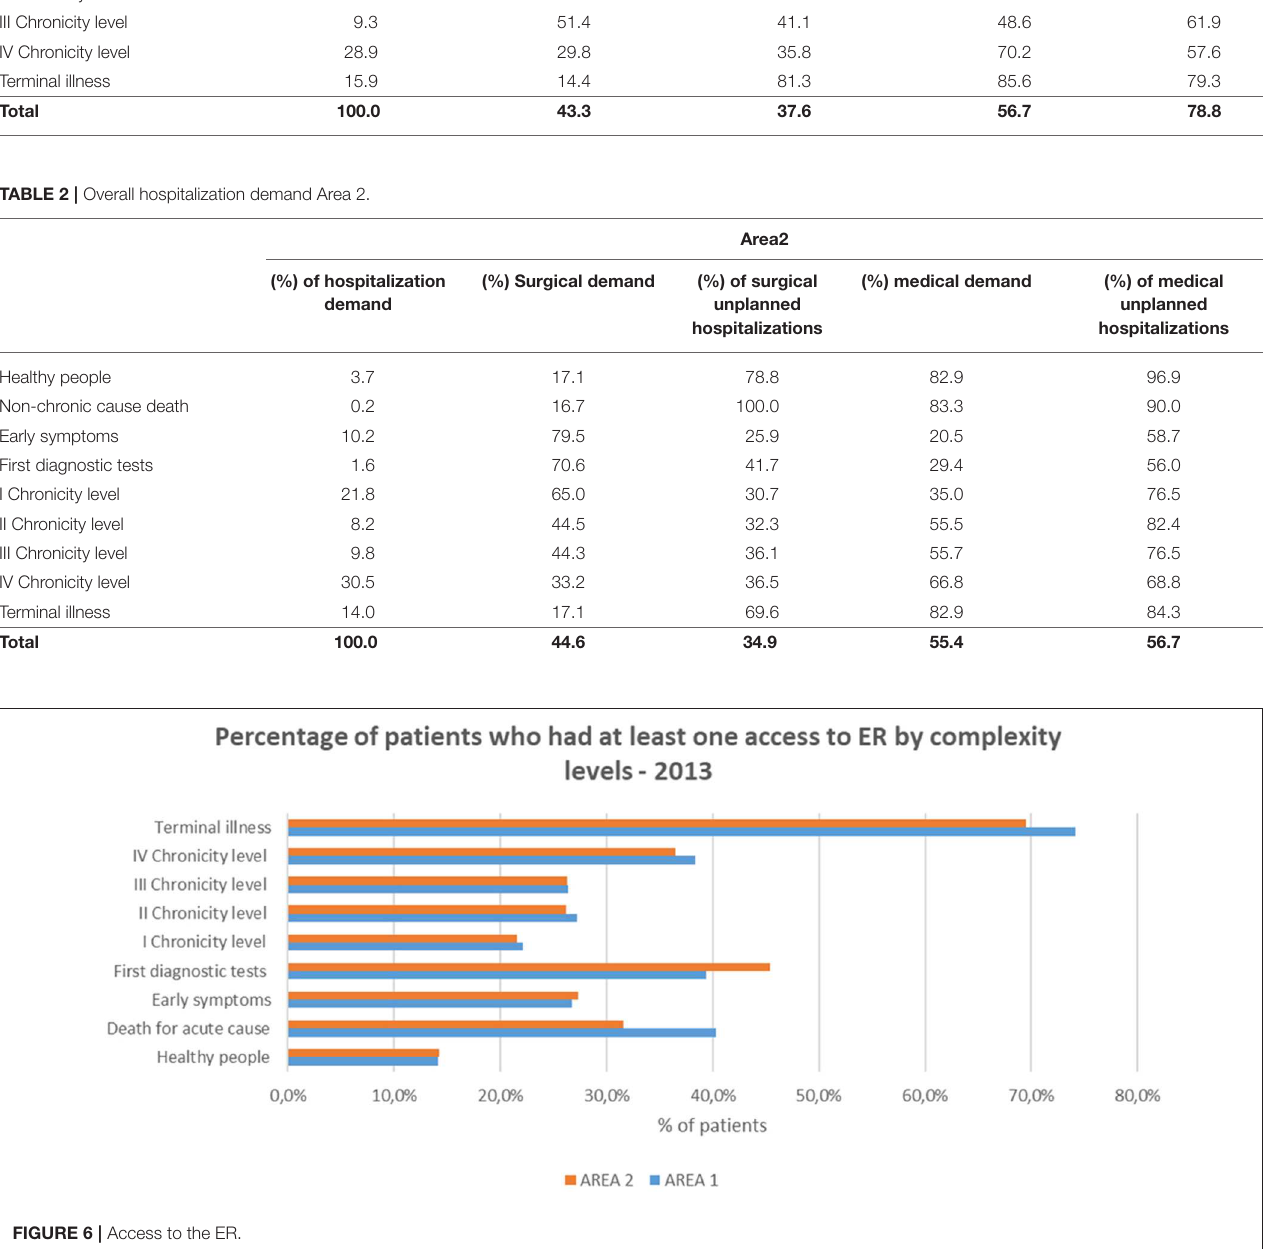
FIGURE 6 | Access to the